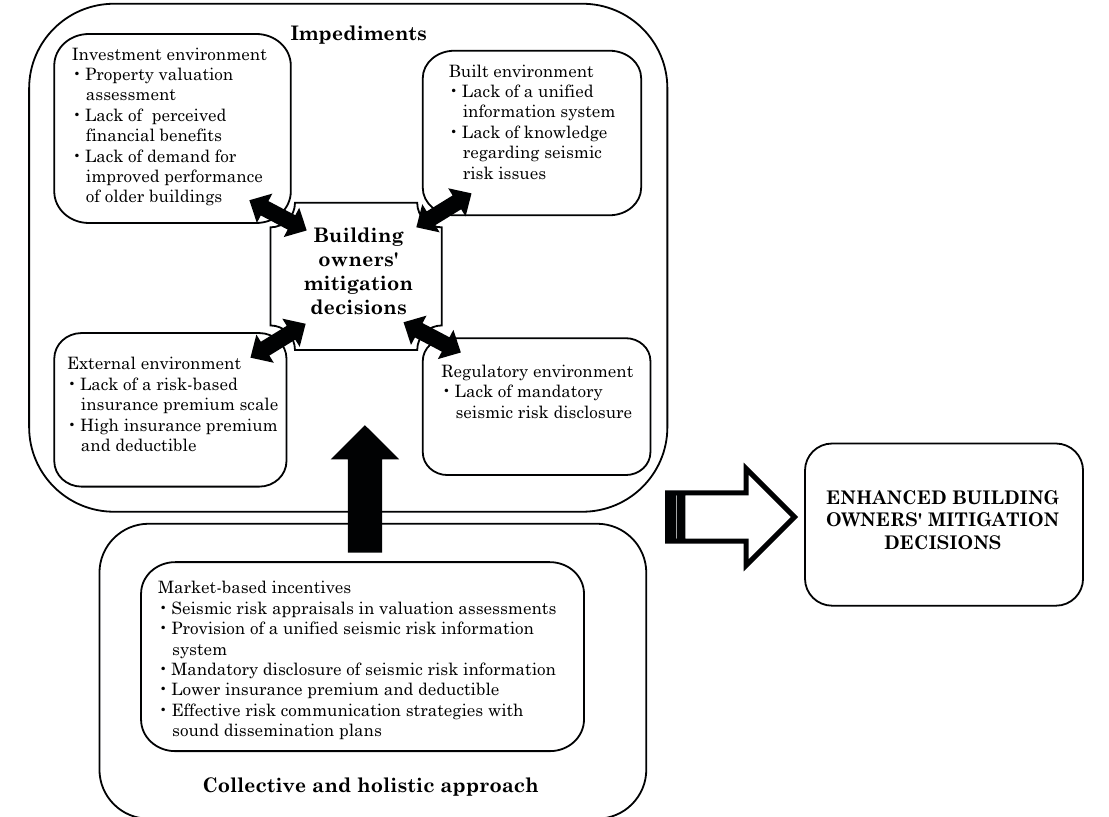
Fig. 2. Framework for enhancing seismic risk mitigation